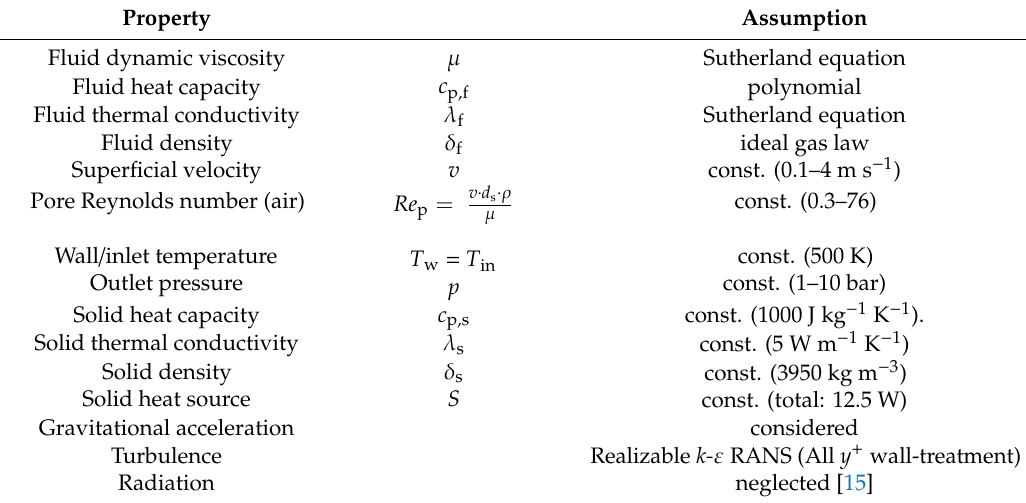
Table 2. Properties of this study’s